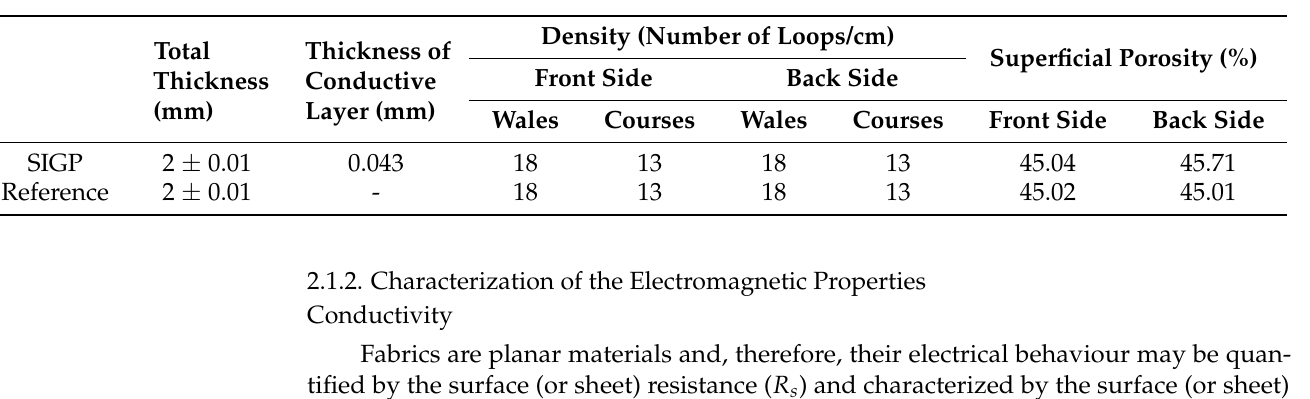
Figure 5. Difference of thickness between samples: ( a ) reference spacer knit and ( b ) SIGP. Where the white, black and brown yarns correspond to the dielectric, spacer and conductive yarns, respectively. Table 1. Structural Parameters of the SIGP and of the reference spacer